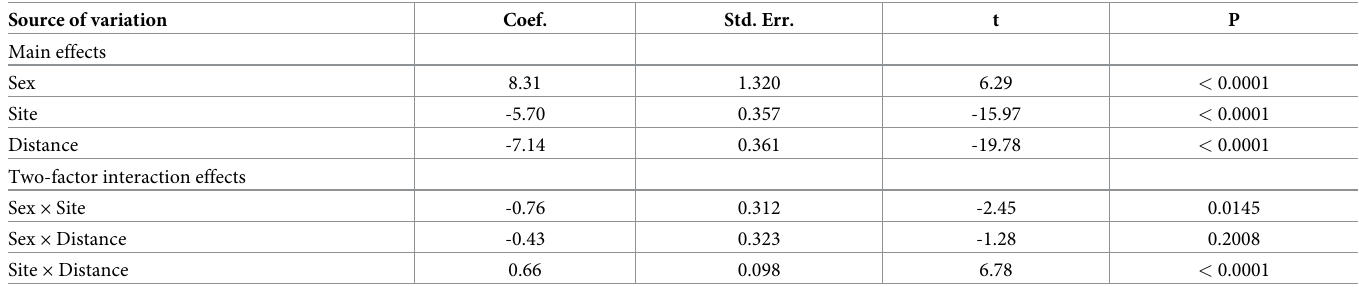
Table 2. Result of the general linear mixed model for signal-to-noise ratio (SNR) of propagated songs of the Yellow-breasted Boubou ( Laniarius atroflavus ). Main and two-factor interactions effects are presented for the following source of variation: sex (male, female), site (transect FOREST, SHRUBS, STREAM) and distance (12.5, 25, 50 and 100 m). Repeated measurements of songs of the same individuals are included as a random factor. Source of variation Coef. Std.